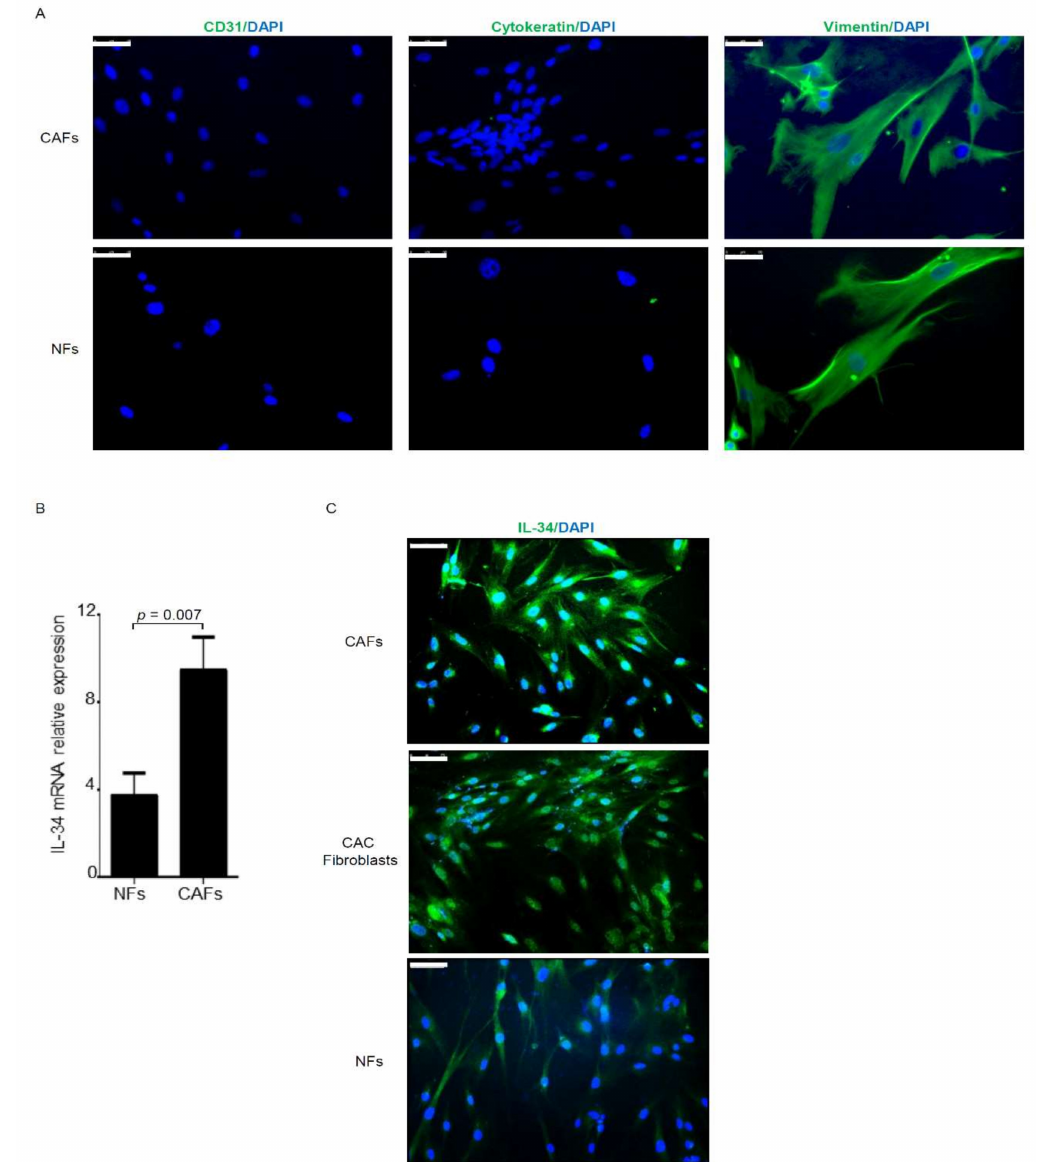
Figure 1. Cancer-associated fibroblasts express interleukin-34 (IL-34). ( A ) Representative images of immunofluorescence staining of fibroblasts isolated from tumoral (cancer-associated fibroblasts—CAFs) and non-tumoral (normal fibroblasts—NFs) area of one patient with colon cancer and analyzed for the expression of CD31 (green), cytocheratin (green), vimentin (green), and DAPI (blue). (Scale bars: 50 µ m). Oneofthreerepresentativeexperiments, inwhichcellsofthreepatientswereused, isshown. ( B )NFsand CAFs were evaluated for the expression of IL-34 by real-time PCR; levels were normalized to β -Actin and data were expressed as mean ± SEM of five patients. ( C ) Representative images of immunofluorescence staining of CAFs and NFs taken from tumoral and non-tumoral area, respectively, of one patient with colon cancer and one patient ulcerative colitis-associated colon cancer (CAC) and analyzed for the expression of IL-34 (green), and DAPI (blue). The example is representative of six separate experiments in which cells of three patients with colon cancer and three patients with CAC were analyzed. The scale bars are 75 µ